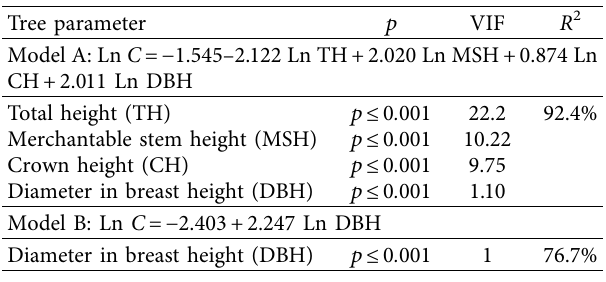
Table 4: The p values and VIF values of different tree parameters and R 2 values of each constructed models (Model A and Model B for Rhizophora mucronata ).